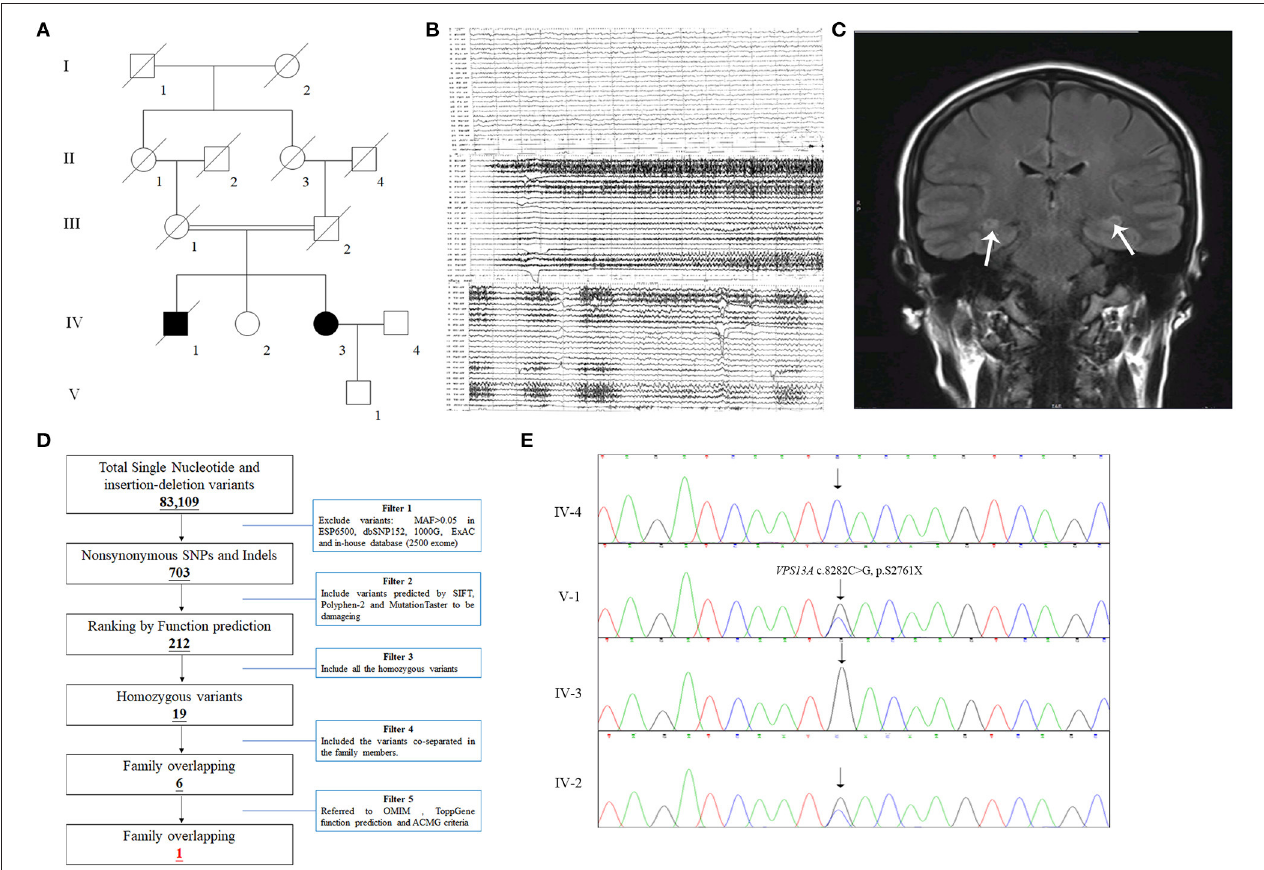
FIGURE 1 | The clinical and genetic data of the family. (A) Pedigree of the family with epilepsy. Double lines indicate consanguineous unions. Square denotes male family member, circle represents female family member, slashed symbol indicates deceased family member, fully shaded symbol shows patient with epilepsy, and open symbol presents no symptoms member. (B) EEG testing of the IV-3 showed frequent abnormal epileptiform discharges in the right temple, and a small amount of epileptiform discharges in the left; (C) MRI scanning of the IV-3 revealed that T2 and T2 flair signals of bilateral hippocampus were slightly higher (the arrows), the hippocampal neuron may be damaged. (D) Schematic representation of the filter strategies employed in this study. (E) Sanger sequencing validated that the patient IV-3 carried a homozygous mutation (NM_033305.2: c.8282C > G, p.S2761X) of VPS13A and her son (V-1) and sister (IV-2) carried the heterozygous mutation.